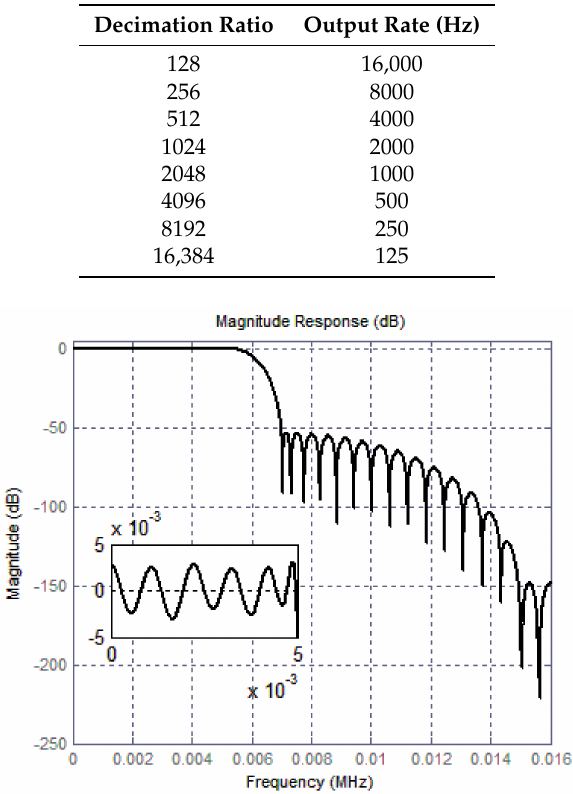
Table 3. Detailed configuration for main indexes (f in = 2048 kHz).